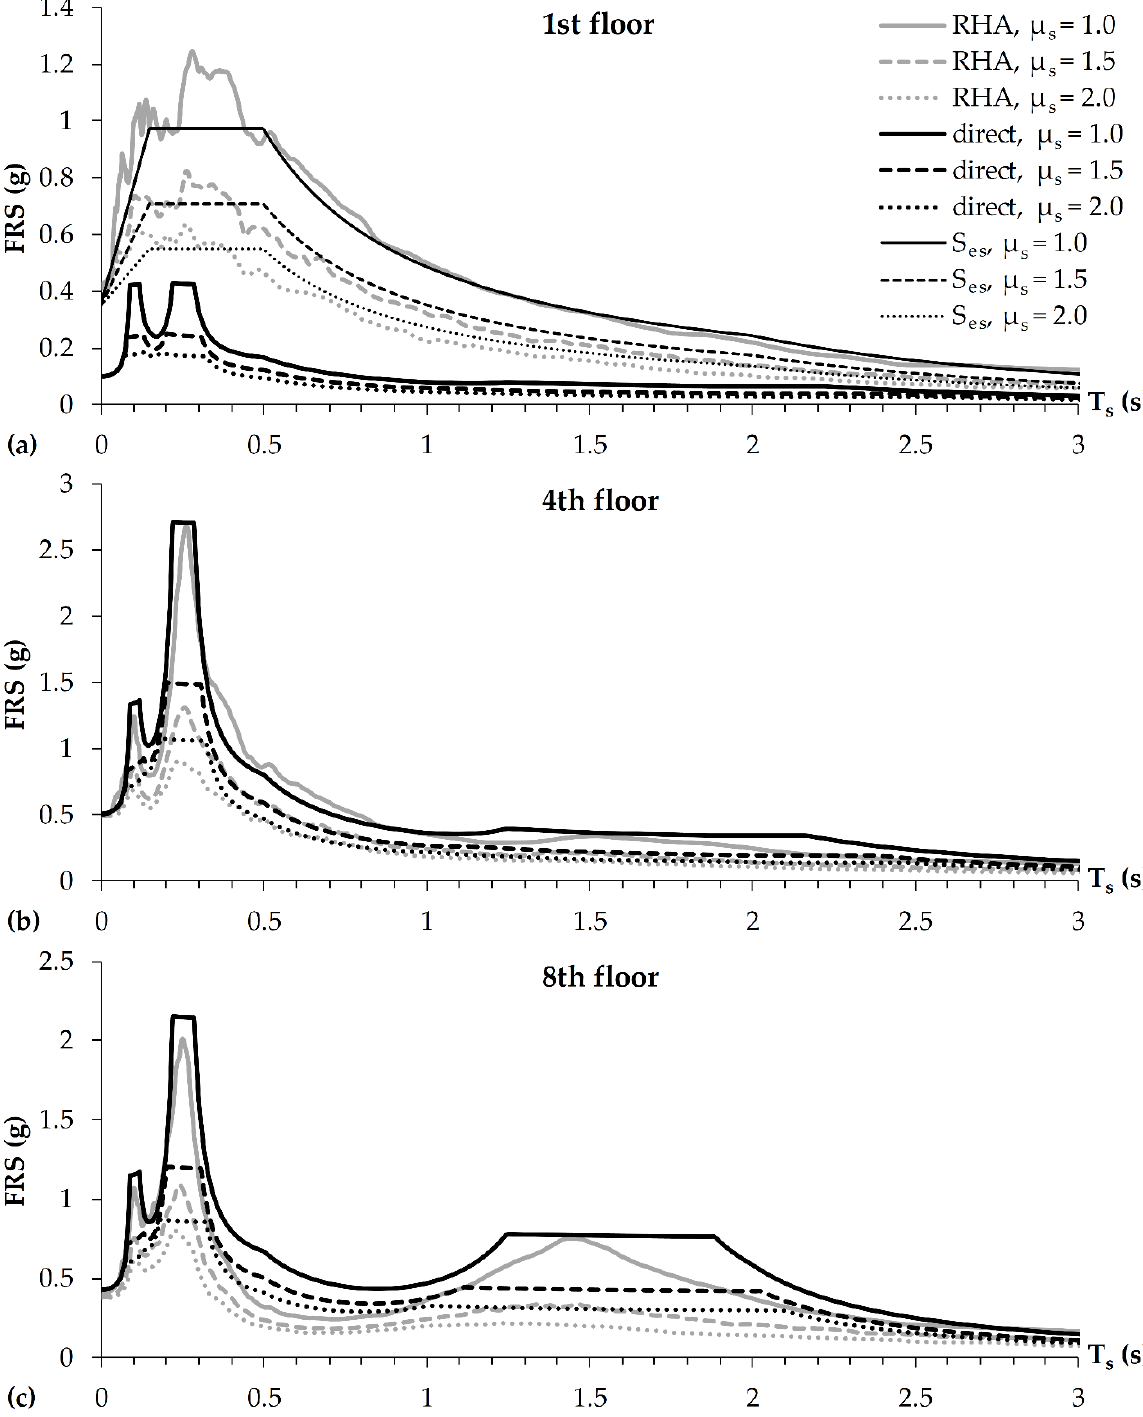
Figure 5. A comparison of FRS from the RHA and direct method for the 1st ( a ), 4th ( b ) and 8th ( c ) floors and input elastic ground response spectra used in the direct method (shown only at the 1st floor).